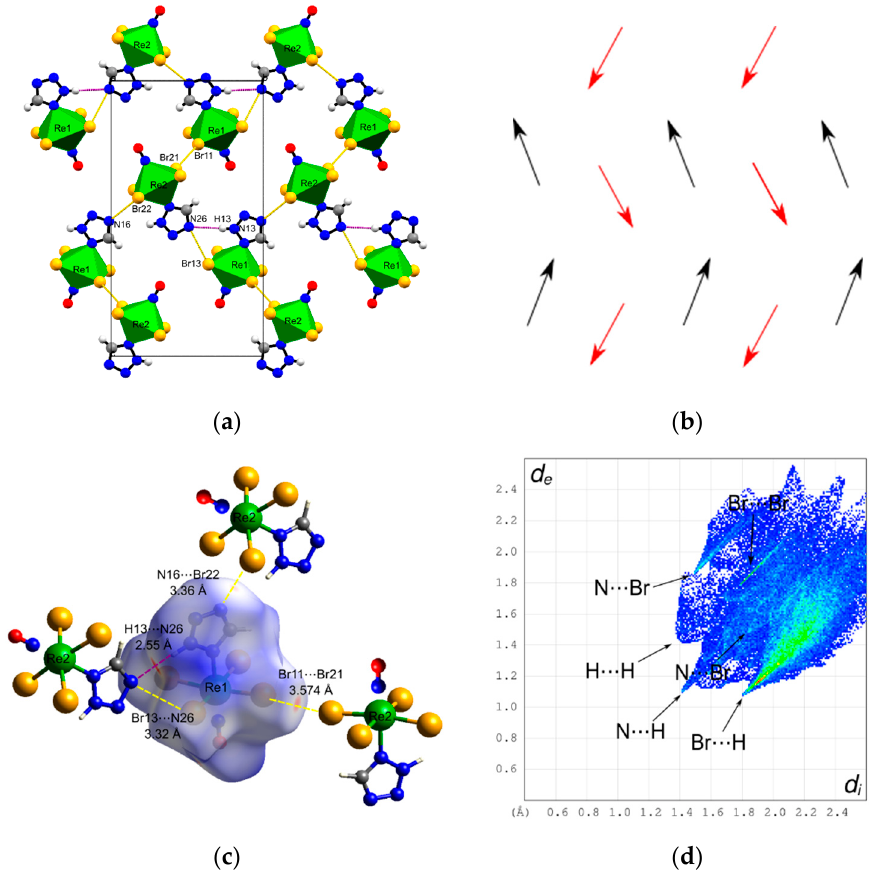
Figure 3. ( a ) Packing diagram down the crystallographic a axis; ( b ) complex anion orientation scheme along the crystallographic a axis (black and red arrows represent the A and B molecules, respectively); ( c ) d norm surface and ( d ) shape index surface of the [Re(NO)Br 4 (Htrz)] − units in 4 . Short through space Br···Br (yellow) and Br···N (yellow) contacts and N–H···N hydrogen bonds (purple) are also shown.